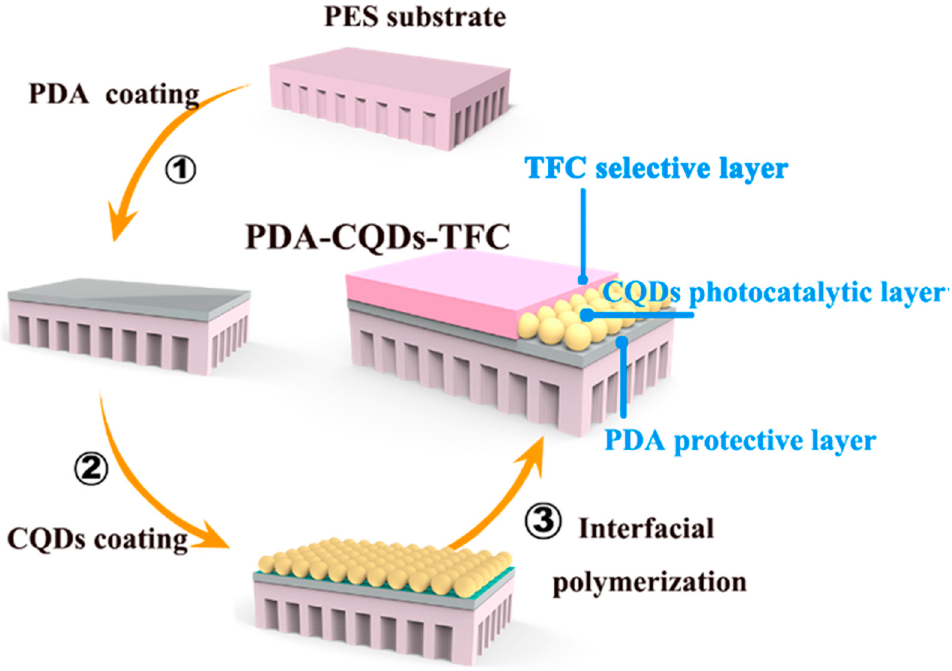
Figure 10. The coating process of a PDA-CD-TFC membrane. Reprinted with permission from [98]. Copyright (2019) American Chemical Society.